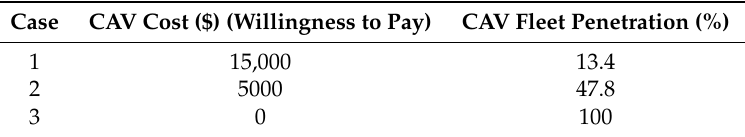
Table 1. CAV case study setup.